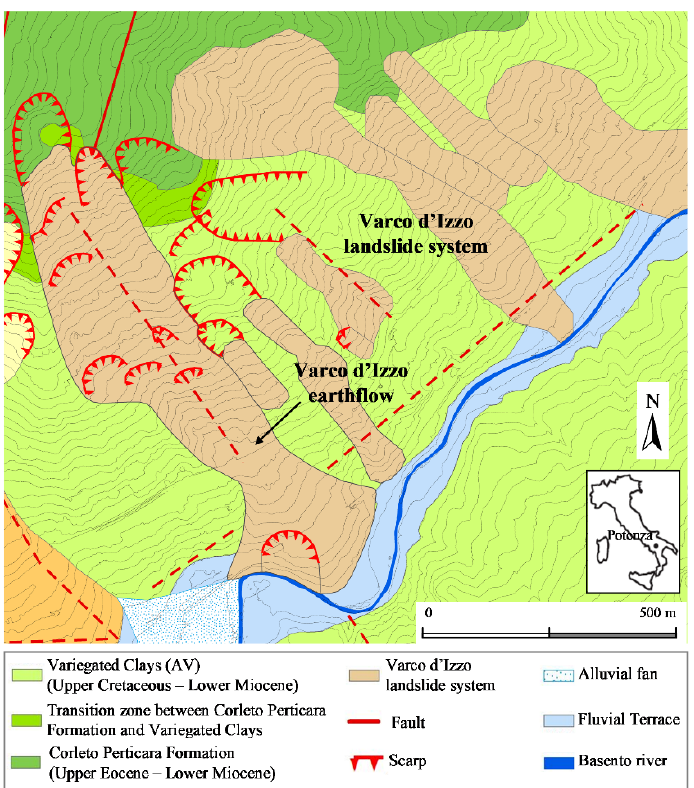
Figure 2. Geological map of the Varco d’Izzo landslide system (redrawn from [29]).